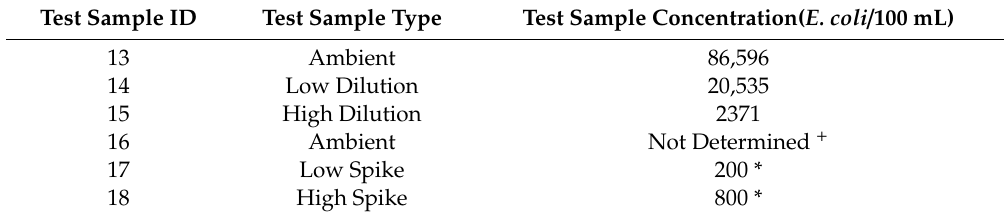
Table 2. Test sample descriptions. Test sample ID’s, type and concentrations as described in Aw et al.,